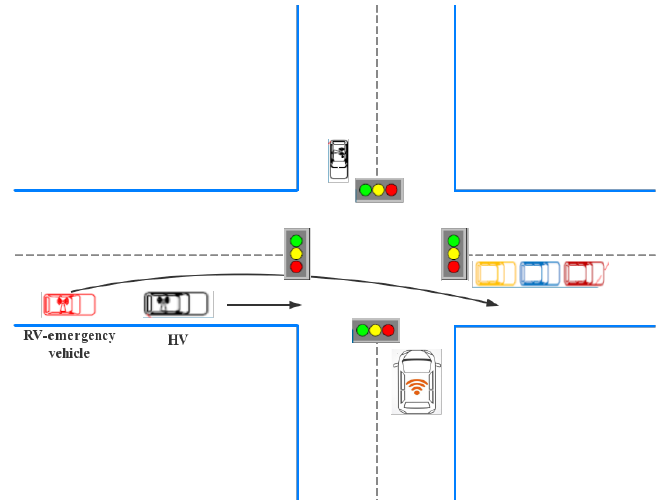
Figure 11. Priority for emergency vehicle scheduling.